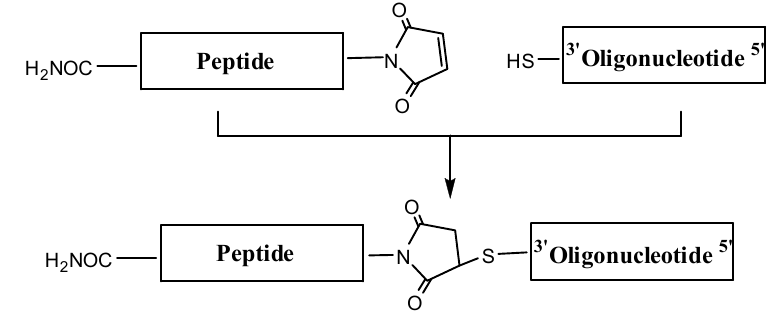
Figure 2. Synthesis of OPCs using maleimido-peptides and thiol-oligonucleotides following the post-synthetic conjugation